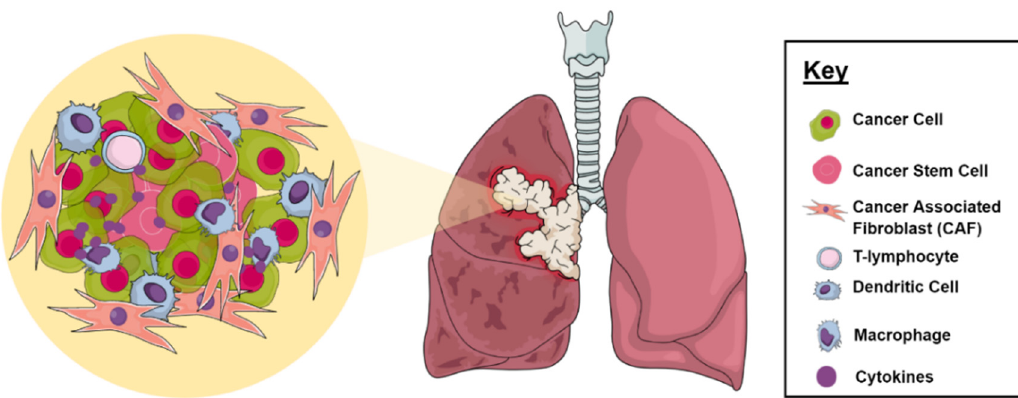
Figure 2. Representation of cellular components of TME in LC.